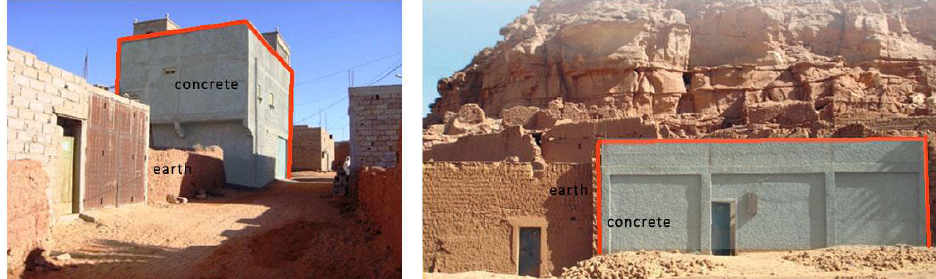
Figure 9 An example for the usage of new construction materials in Ksar (Produced from Rouani, 2017).